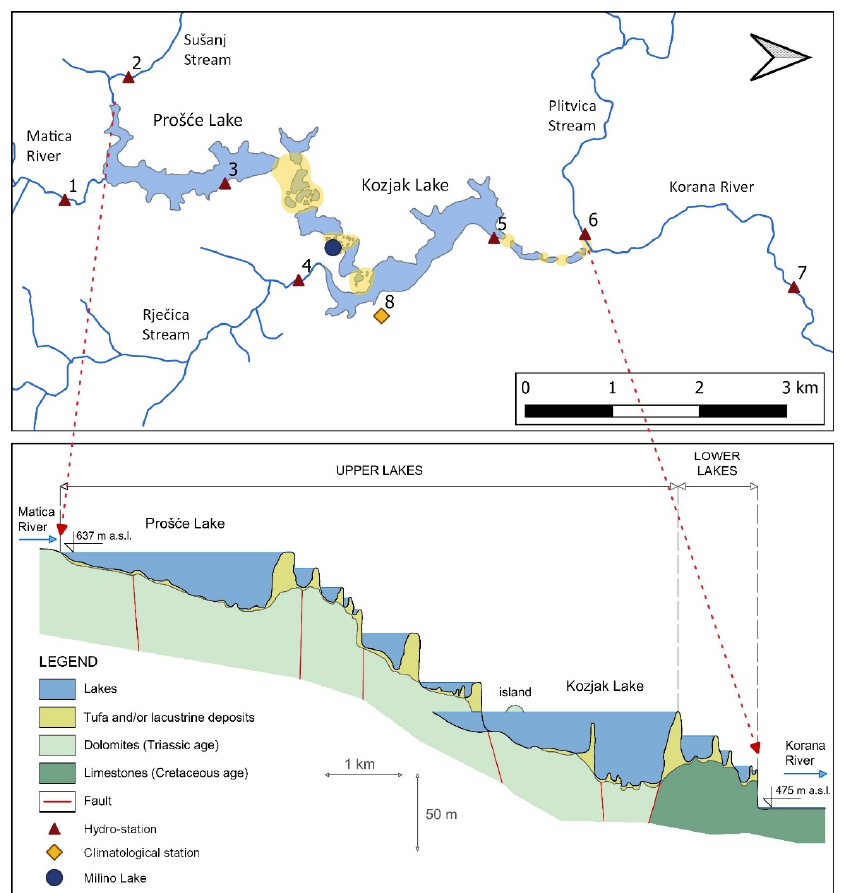
Figure 5. Schematic hydrogeological cross ‐ section of the Plitvice Lakes water resource system and presentation of the locations of hydrological stations (1—Matica; 2—Sušanj; 3—Proš ć e Lake; 4— Rje č ica; 5—Kozjak Lake; 6—Plitvica; 7—Korana ‐ Luketi ć i), Plitvi č ka jezera climatological station (8), and Milino Lake.